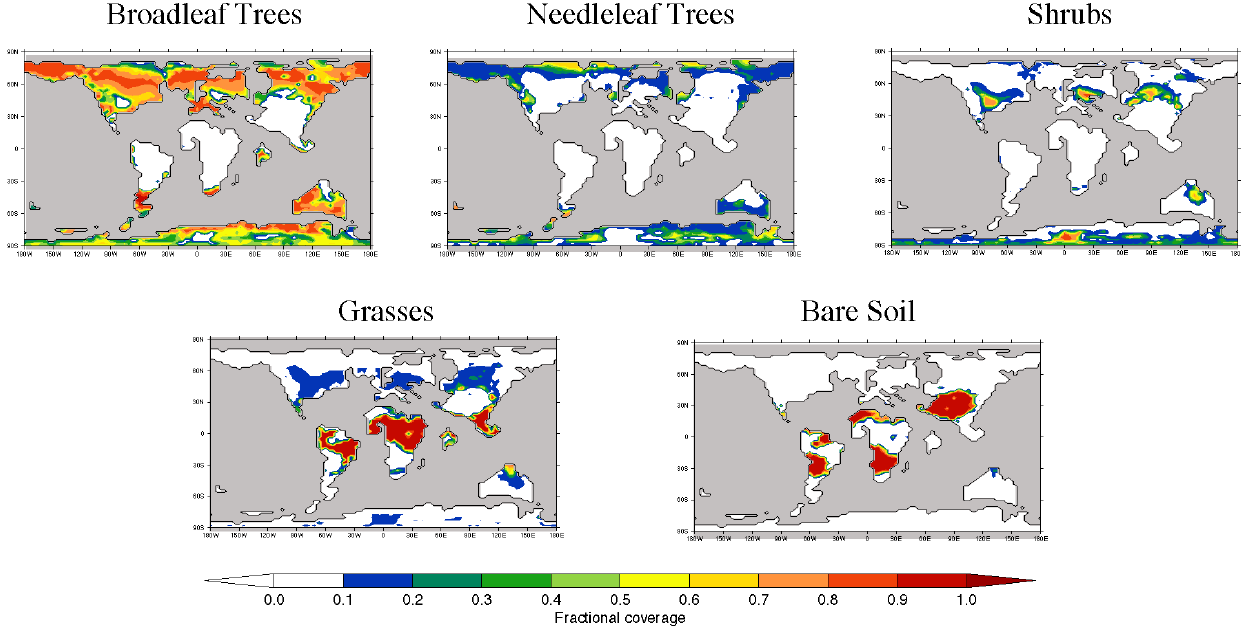
Fig. 2. Global early Eocene vegetation distributions for 4 × DYN as predicted by TRIFFID.